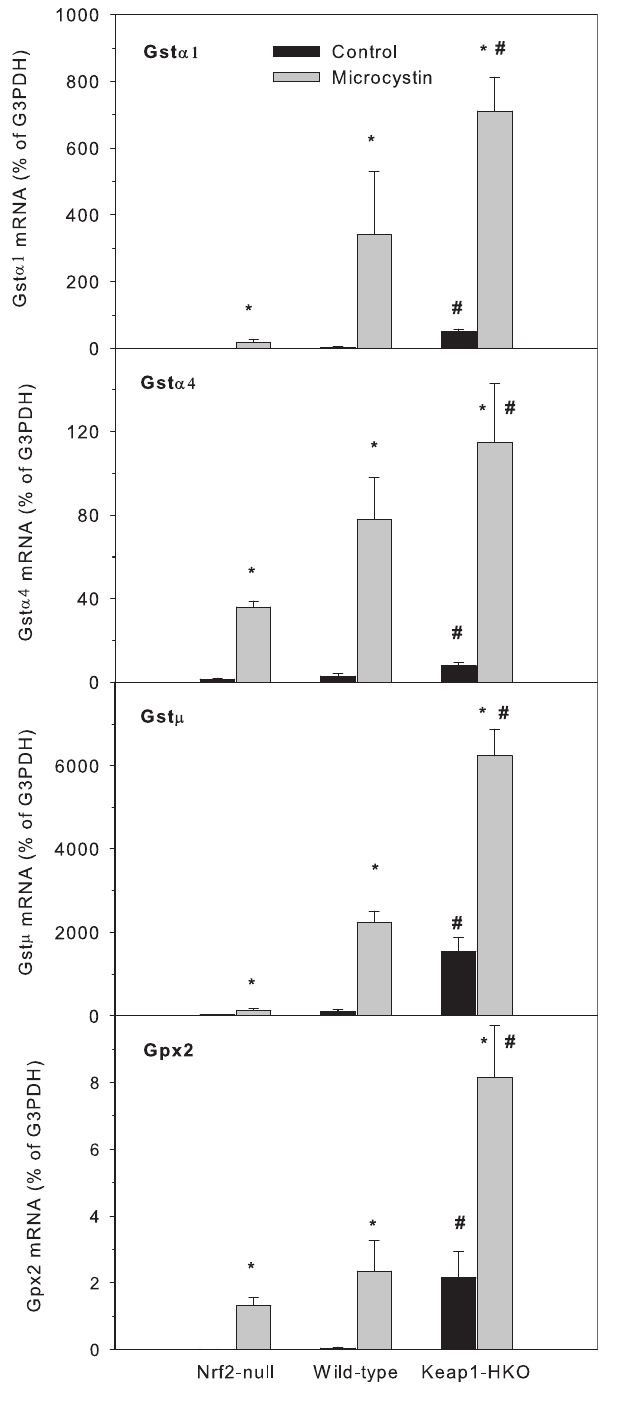
Figure 7. mRNA levels of heme oxygenase-1 (Ho-1, top) and early growth response protein-1 (Egr1) in Nrf2-null, wild-type and Keap1-HKO mice administered saline (10 ml/kg, i.p.) or microcystin (50 m g/kg, i.p.). Values are expressed as mean 6 S.E.M. (n=8). *significantly different from the basal level of the same genotype (p # 0.05); # significantly different from Nrf2-null mice treated with microcystin (p # 0.05). doi:10.1371/journal.pone.0093013.g007 fold in Nrf2-null mice and wild-type mice, but 4.5-fold in Keap1- HKO mice.